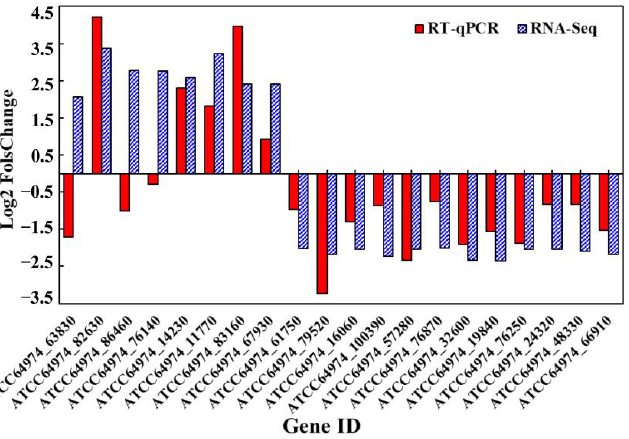
Figure 8. Validation of DEGs by comparing qRT-PCR analysis and RNA-Seq analysis.